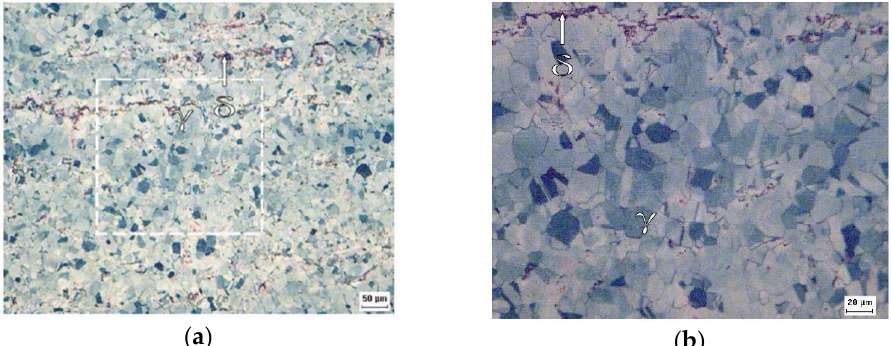
Figure 4. Micrographs obtained by optical microscopy of the B0 sample at ×200 ( a ) and ×500 ( b ) of magnification after the Behara’s reagent attack.